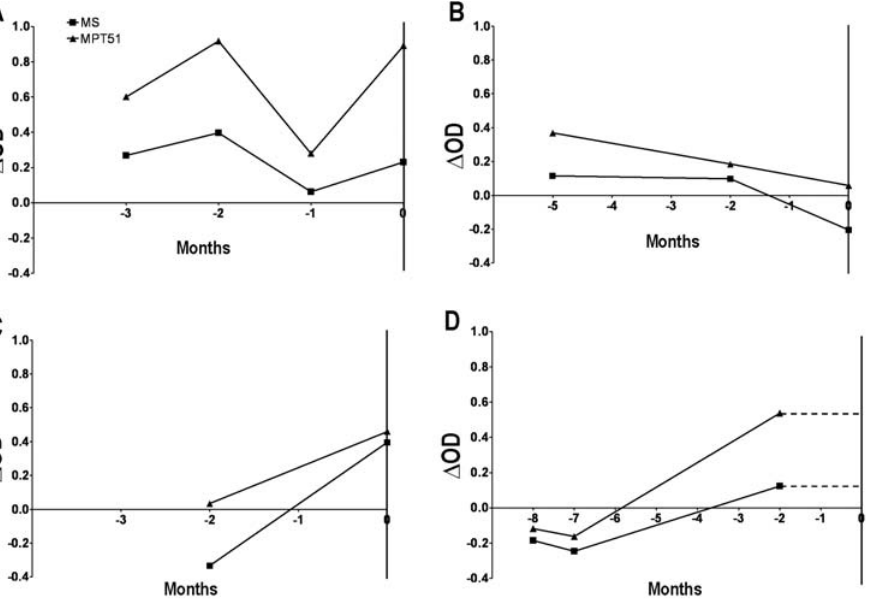
Figure 4. Presence of anti-MS and anti-MPT51 antibodies during subclinical TB: Presence of the two biomarkers in retrospective sera obtained during the months prior to manifestation of clinical TB in 4 HIV + TB + patients is shown. Time 0 represents the time point at which clinical TB was diagnosed; negative values refer to months preceding time 0. Delta OD (optical density) represents the OD obtained with the individual serum specimen minus the mean OD plus 3 standard deviations obtained with the PPD + /PPD 2 healthy subjects in the ELISA. For patient depicted in ‘D’, no specimen was obtained at time of clinical diagnosis of TB.